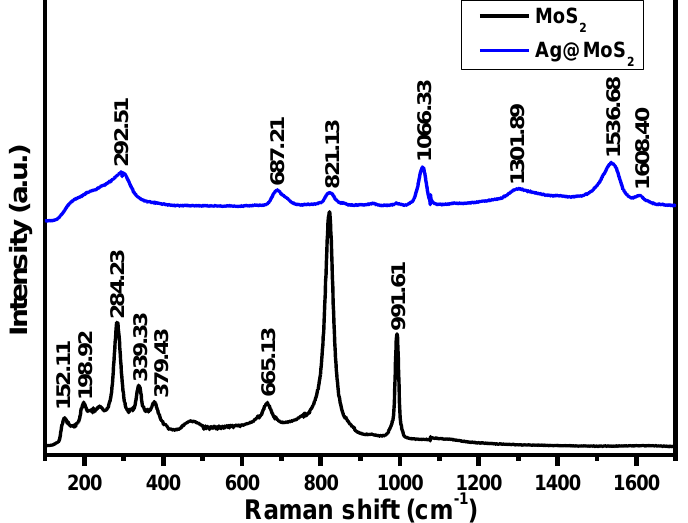
Figure 2. Raman spectra of MoS 2 and Ag-MoS 2 composites.